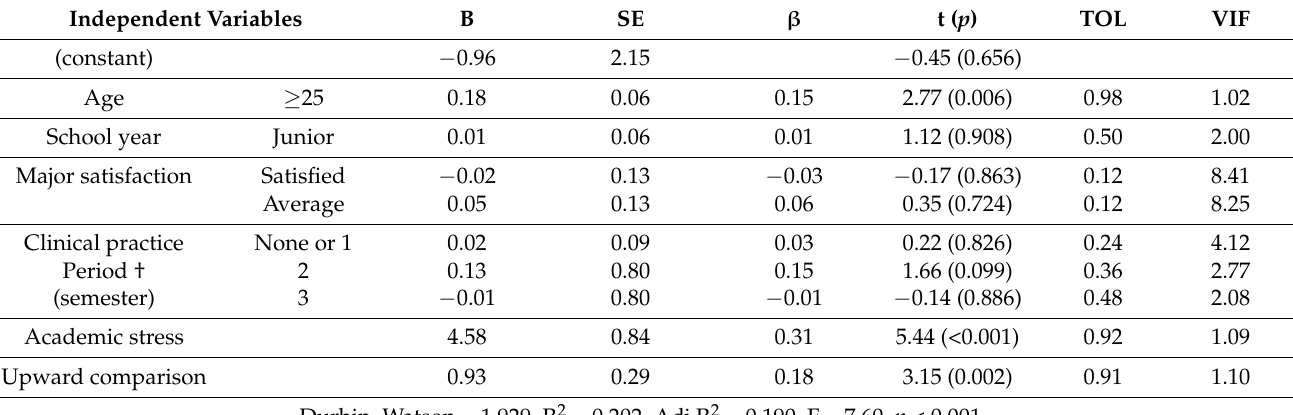
Table 3. Factors Influencing Depression ( n =